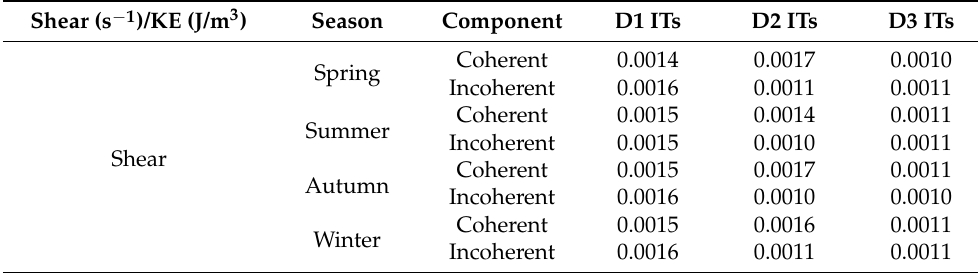
Table 4. Time–depth averaged shear and kinetic energy densities of the coherent and incoherent components of D1, D2, and D3 ITs in four